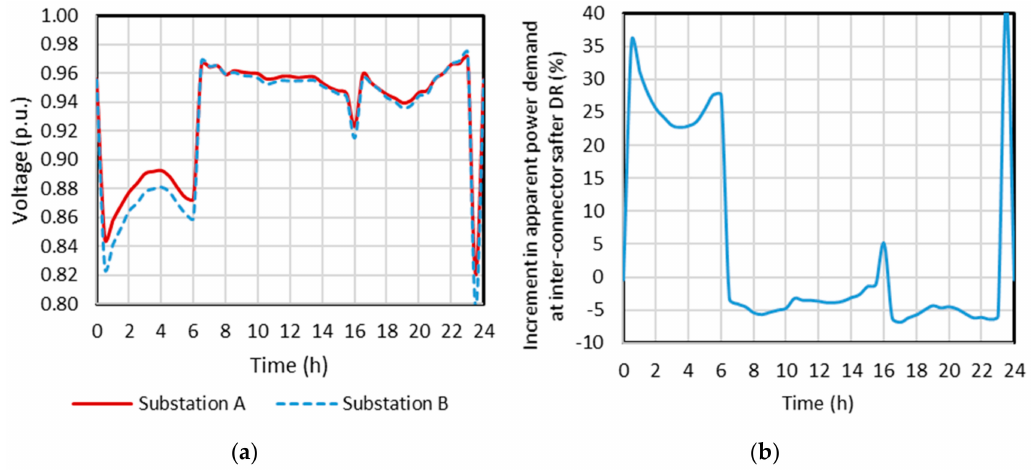
Figure 11. ( a ) Secondary voltage at transformers of both substations and ( b ) increment in apparent power flow through inter-connectors after the implementation of DR for scenario 3.